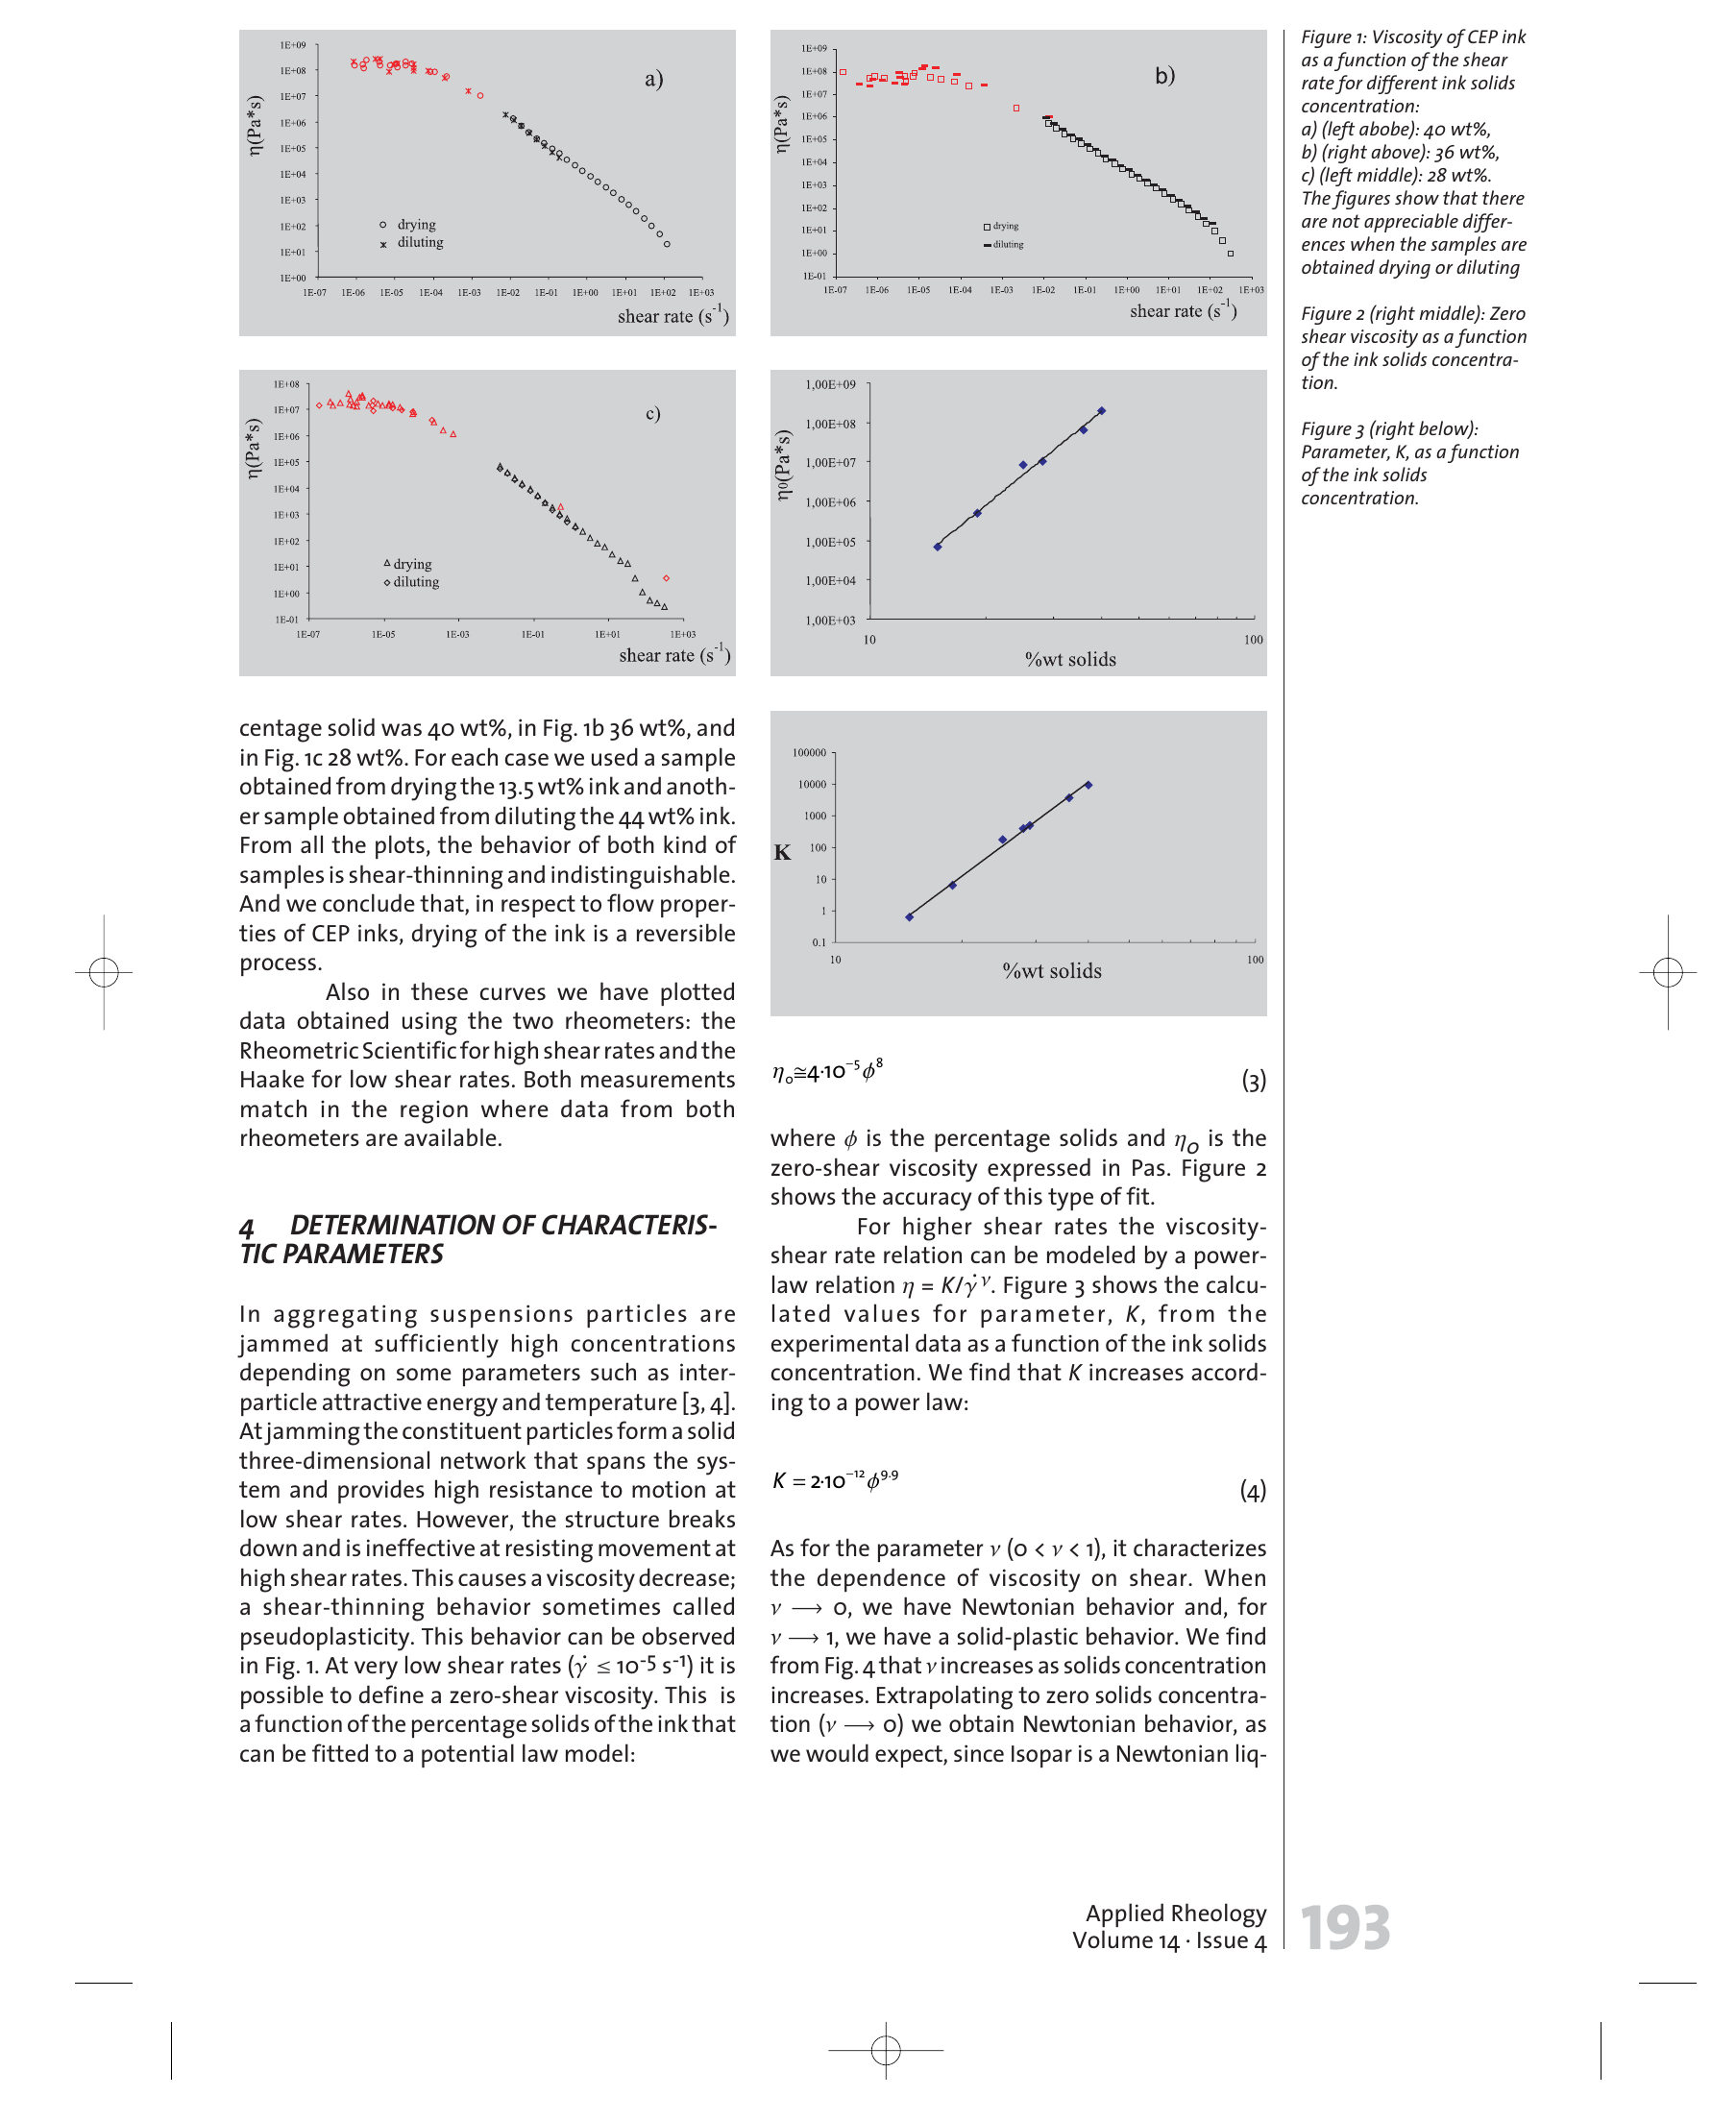
Figure 1: Viscosity of CEP ink as a function of the shear rate for different ink solids concentration: a) (left abobe): 40 wt%, b) (right above): 36 wt%, c) (left middle): 28 wt%. The figures show that there are not appreciable differ- ences when the samples are obtained drying or diluting Figure 2 (right middle): Zero shear viscosity as a function of the ink solids concentra- tion. Figure 3 (right below): Parameter, K, as a function of the ink solids